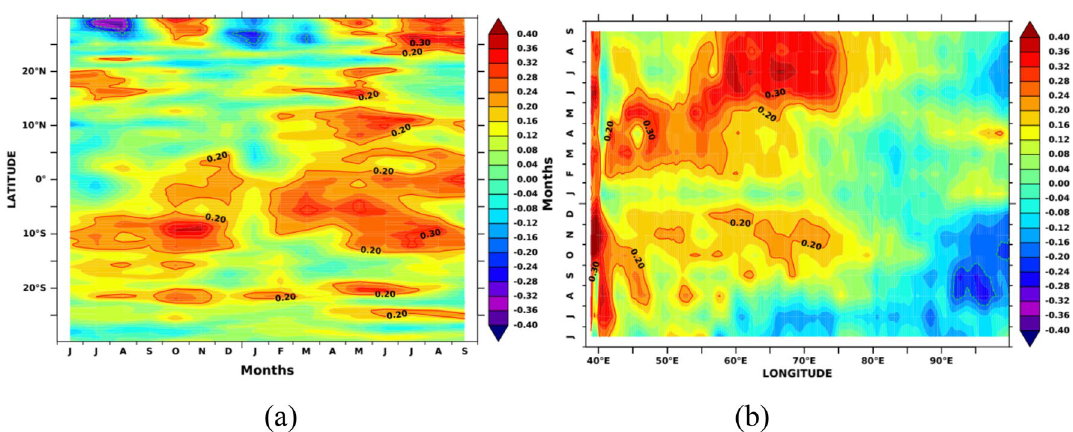
Figure 13. ( a ) Monthly lagged cross-correlation between AISMR SAI and MSLA averaged over 40-65E and ( b ) over 10S-10N. The figure is generated using PyFerret